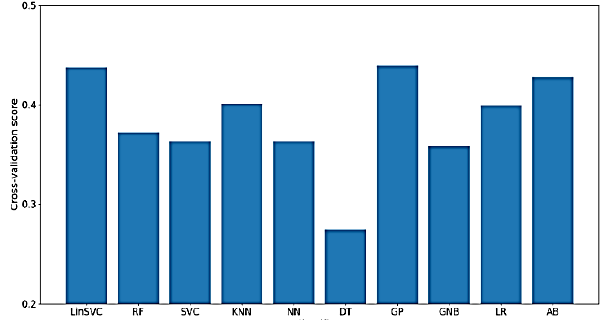
Figure 15. Performance of implemented classifiers for the classification of WM scores using raw data and only time-domain features.